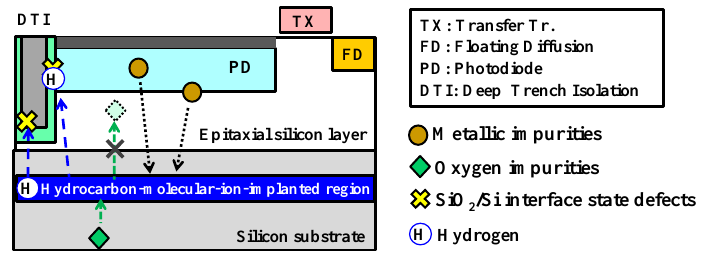
Figure 1. Three characteristics of hydrocarbon-molecular-ion-implanted epitaxial silicon wafer for CMOS image sensor fabrication process.